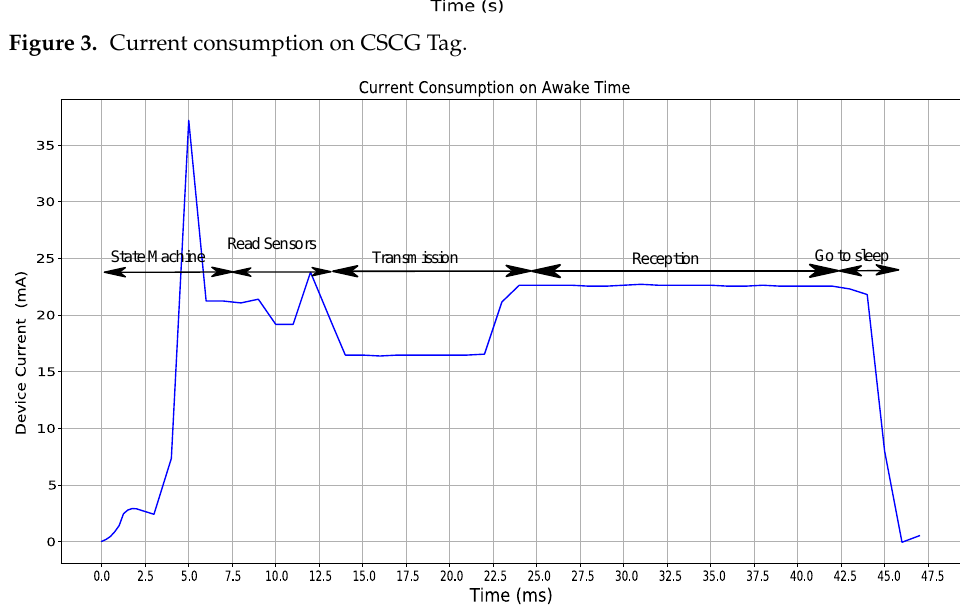
Figure 4. Current consumption during awake time. Equation (1) shows average total current consumed by an IoT device defined as the sum of current consumption multiplied by its duration divided by total time